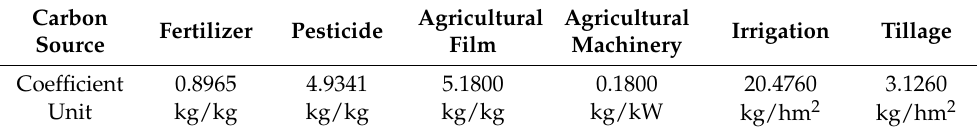
Table 4. Carbon emission sources and coefficients of cultivated land